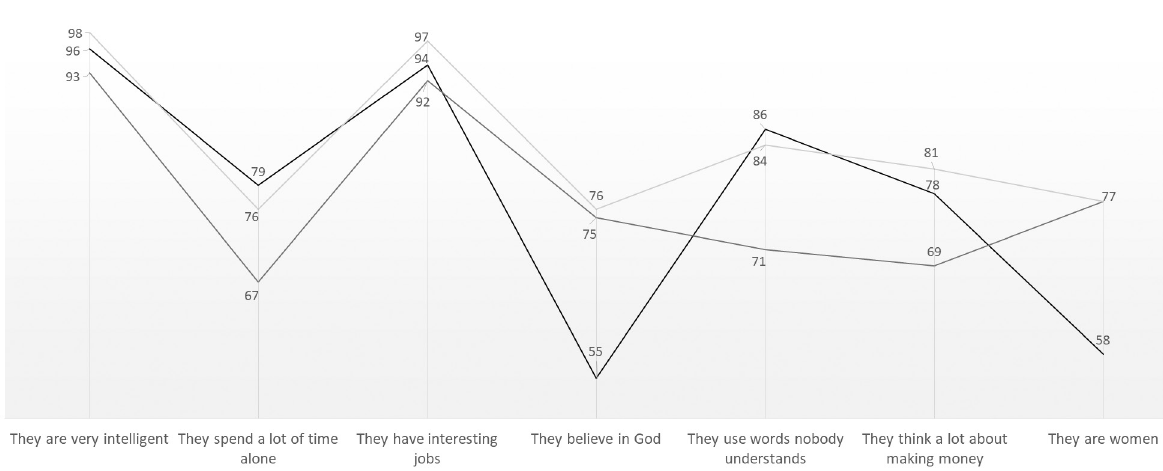
Figure 2. Traits attributed to scientists from different fields (“likely” + “very likely”). Survey questions related to Figure